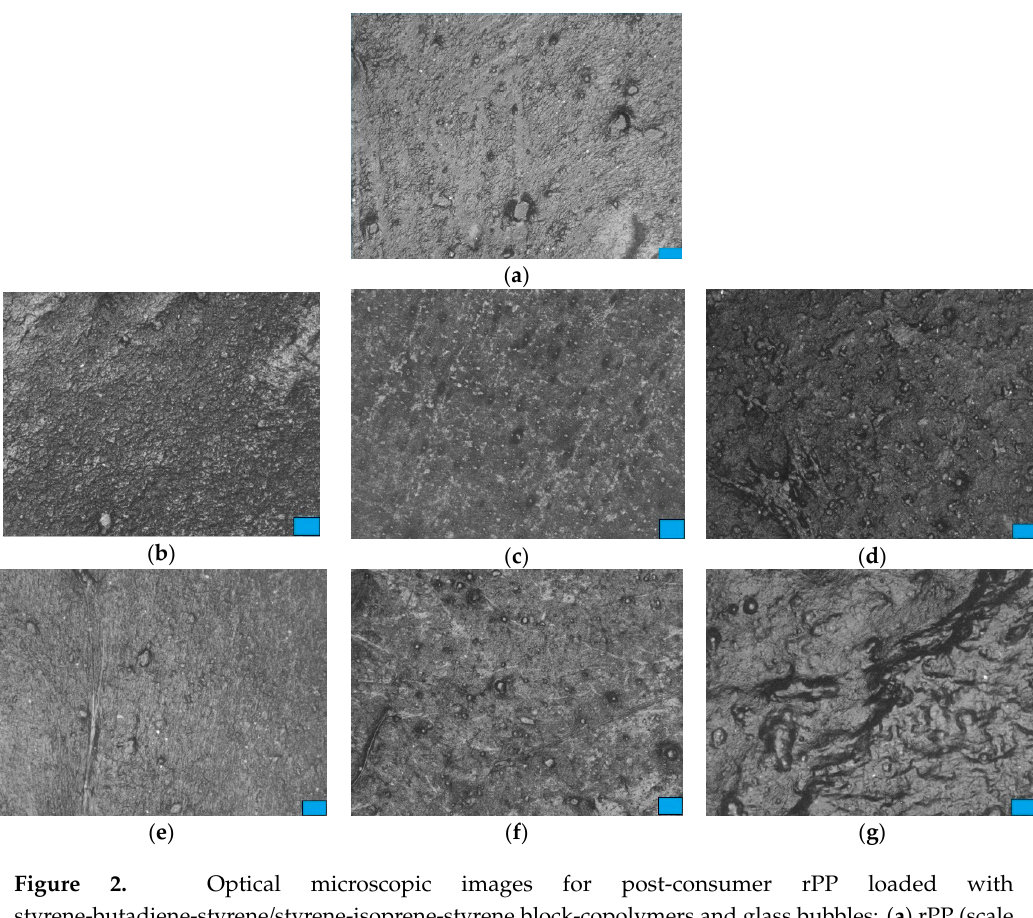
Figure 2. Optical microscopic images for post-consumer rPP loaded with styrene-butadiene-styrene/styrene-isoprene-styrene block-copolymers and glass bubbles: ( a ) rPP (scale bar 200 μ m); ( b ) rPP/SBS (scale bar 130 μ m); ( c ) RPP/SBS/GB 5 (scale bar 200 μ m); ( d ) rPP/SBS/GB 20 (scale bar 100 μ m); ( e ) rPP/SIS (scale bar 50 μ m); ( f ) rPP/SIS/GB 5 (scale bar 100 μ m); ( g ) rPP/SIS/GB 20 (scale bar 50 μ m).